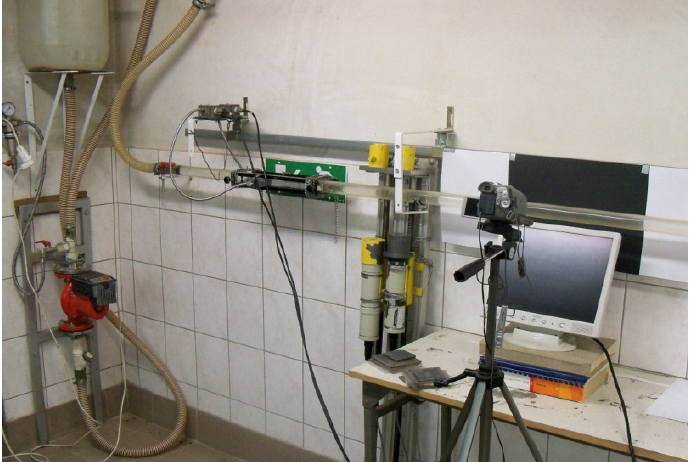
Figure 2. View of the measuring part of the hydraulic installation for liquid–gas flow tests in a horizontal pipeline.